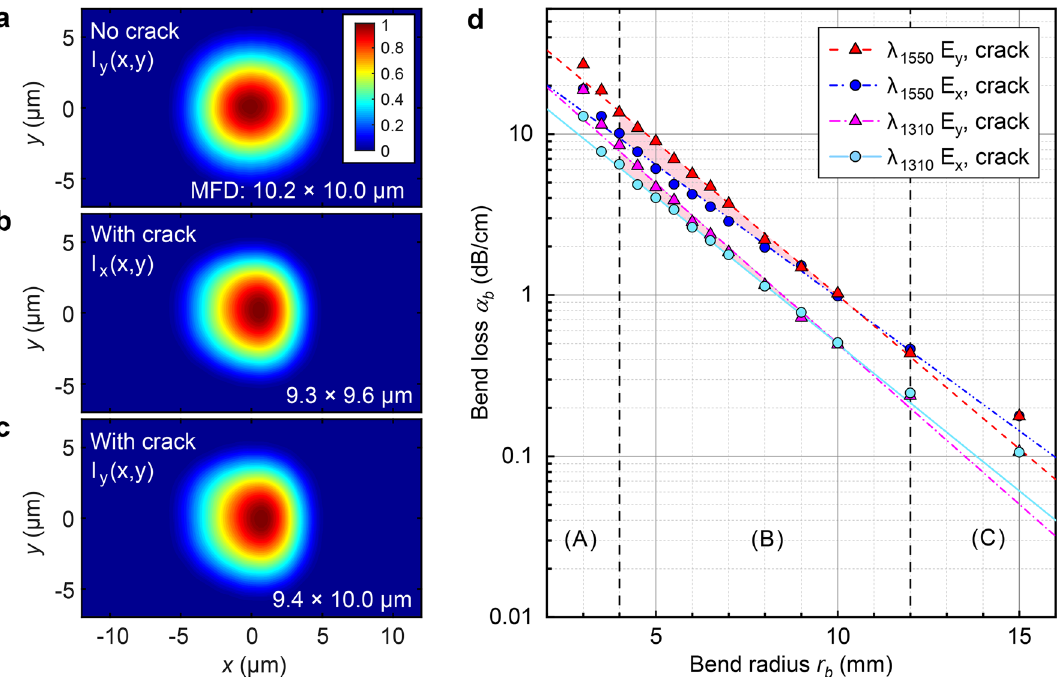
Figure 5. Experimentally measured waveguide mode profiles and bend loss. Mode intensity profiles for straight waveguides ( a ) without microcrack for y polarization ( b ) with microcrack for x polarization and ( c ) y polarization. Crack is on right side of waveguide and peak intensity normalised to unity. The 1/ e 2 mode field diameters in the x and y dimensions are labelled. ( d ) Measured bend loss α b against bend radius r b , for both polarizations at (cid:31) = 1550 nm and 1310 nm. Shaded region denotes polarization-dependent loss. Vertical lines divide the bend radius into 3 ranges A, B and C, where dominant losses are excessive confinement loss, bend loss, and scattering losses,